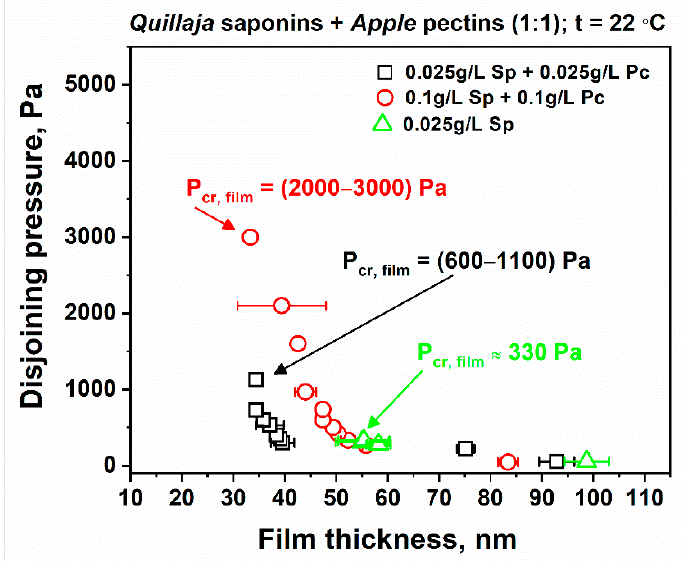
Figure 7. Disjoining pressure vs. film thickness isotherms of microscopic foam films from Quillaja saponin solution and its mixture with Apple pectins at 1:1 (g/L, by weight).